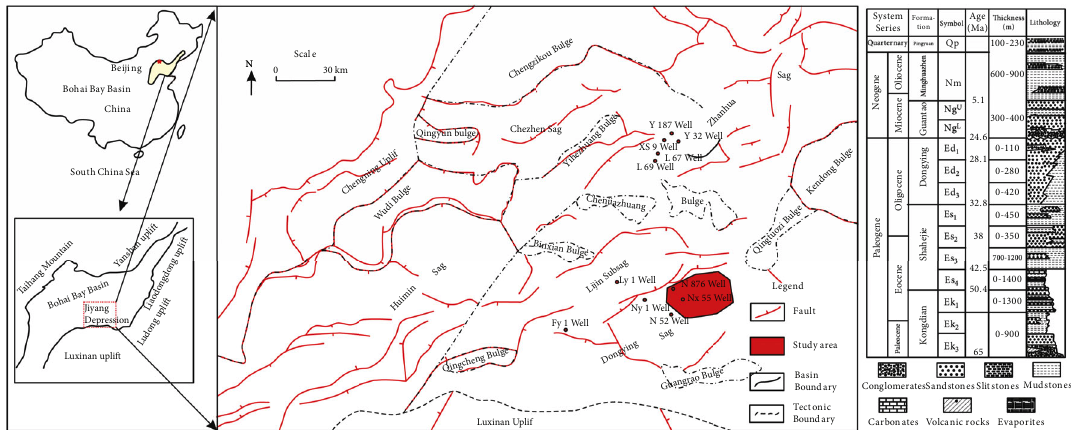
Figure 1: Location of the exploration wells for primary shale oil reservoirs in the Dongying Sag.